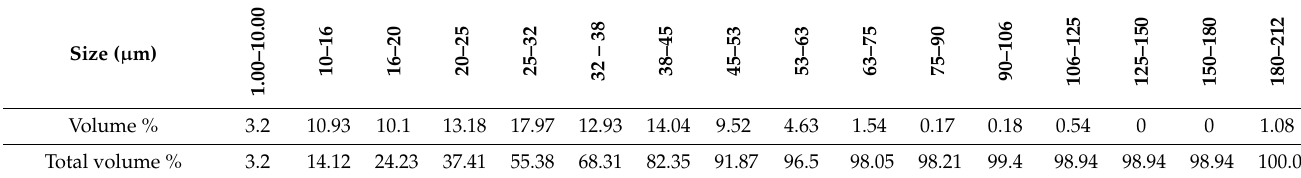
Table 2. Powder particle size distribution.